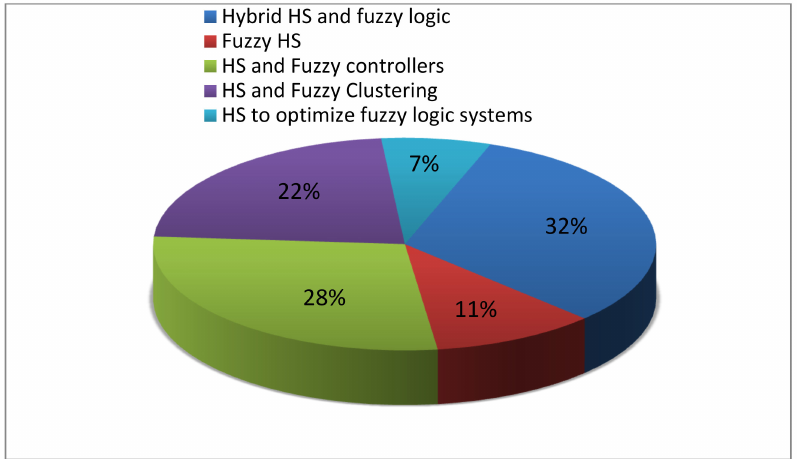
Figure 10. Distribution of reported articles according to the combination type of HS and FL (2007~22 August